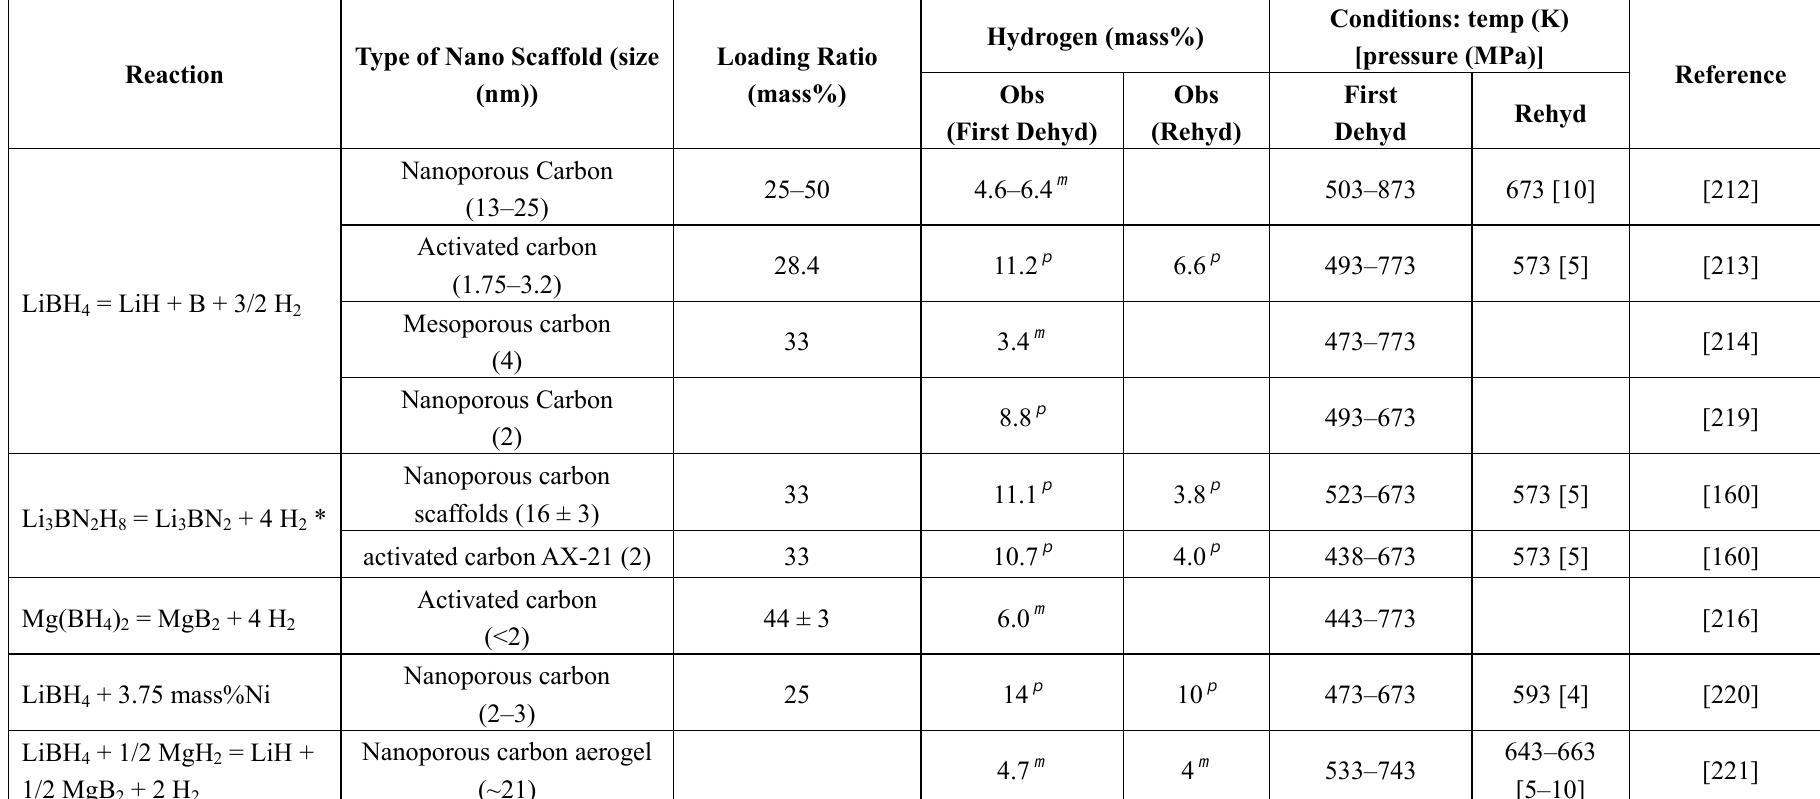
) confined by nanoporous 4 n